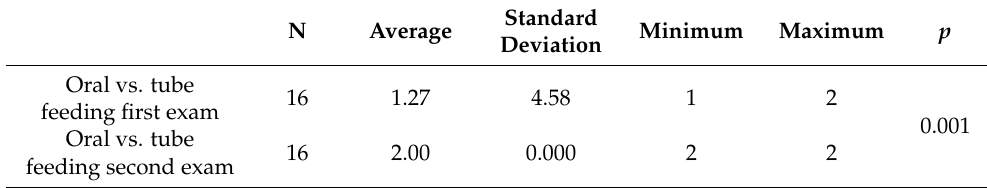
Table 4. The ability of oral feeding before and after parental education and early intervention. Standard Minimum Maximum p N Average Deviation Oral vs. tube 16 1.27 4.58 1 2 feeding first exam 0.001 Oral vs. tube 16 2.00 0.000 2 feeding second exam